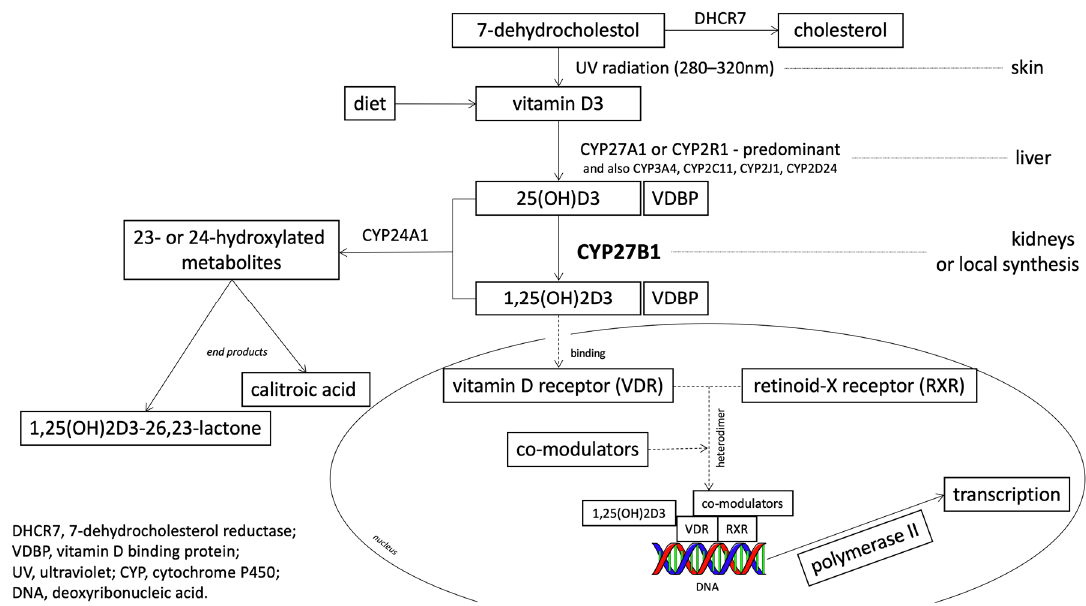
Figure 2. Location of CYP27B1 activity in the metabolic pathway of vitamin D (based on Jenkinson 2019 [13] and Feldman et al. 2014 [1], with own modifications).